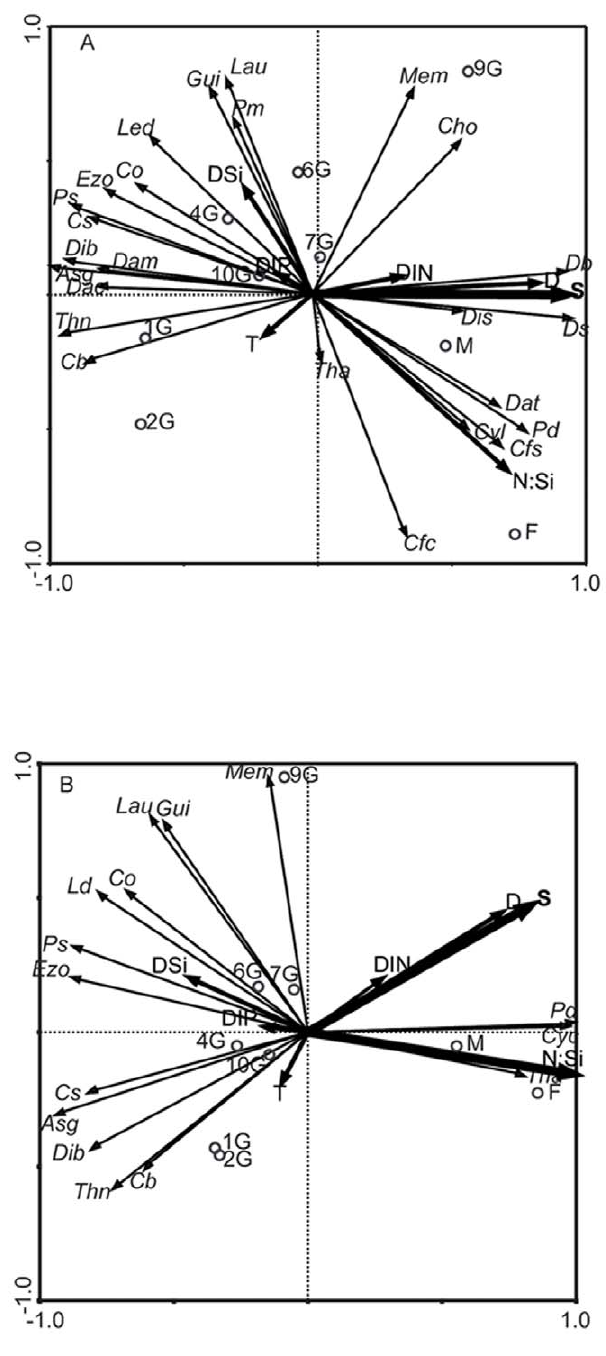
Figure 11. RDA correlation triplots of the relationship between phytoplankton and environmental variables. RDA of samples taken in the upper 100 m of the water column along the Ellett Line transect. a) whole phytoplankton assemblage data b) diatom species only. Analysis was based on the relative phytoplankton abundance (standardized by norm). Sampled stations are indicated by circles, phytoplankton species and environmental variables are represented by arrows with bold typeface being used for those environmental variables that were statistically significant. Environmental abbreviations: S: salinity, T: temperature, D: density, DIN, DIP, DSi: concentrations of inorganic nitrogen, phosphorous and silicon respectively, N:Si: the inorganic DIN:DSi ratio. Species abbreviations: Asg ,